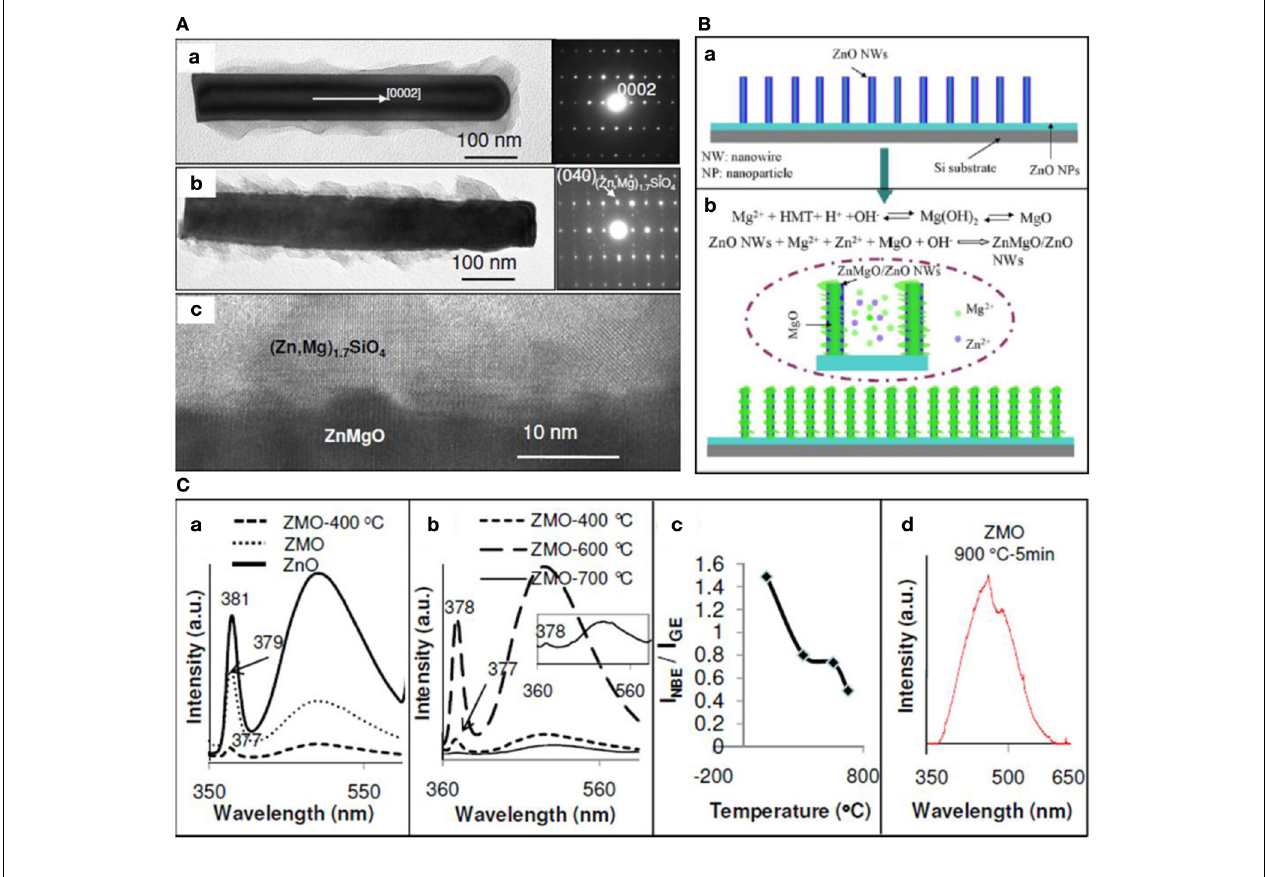
FIGURE 3 | TEM characterization of ZnMgO nanowire arrays; hydrothermal synthesis and growth mechanism of ZnMgO nanowires; photoluminescence spectra ZnMgO at different temperature. (A) TEM characterization of ZnMgO nanowires. (B) Illustration of the hydrothermal